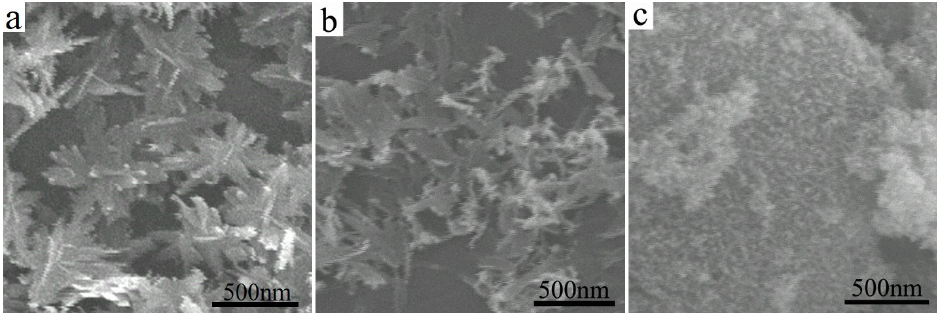
Figure 2. SEM images of CuO nanosheets with different copper sources: ( a ) CuSO 4 ·5H 2 O, ( b ) CuNO 3 ·3H 2 O, and ( c ) Cu(CH 3 COO) 2 ·H 2 O.